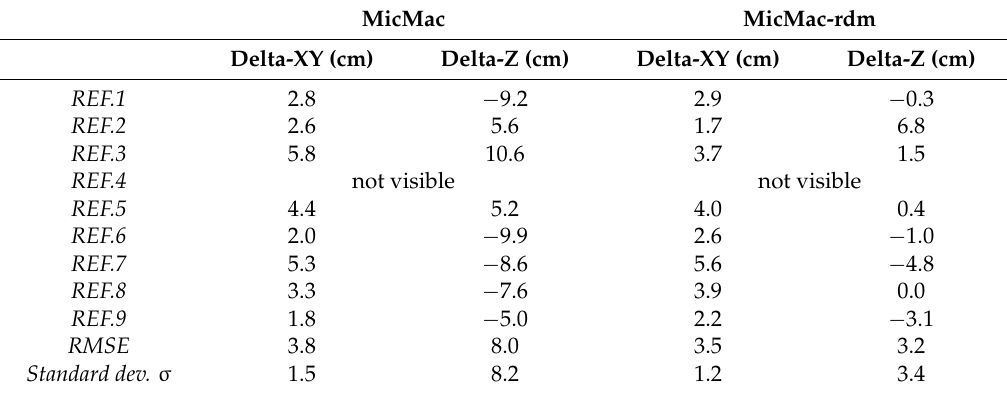
Table 1. Accuracy of the reconstruction with scenario 1 using MicMac and MicMac with the refined distortion model (MicMac-rdm). Delta-XY and Delta-Z are respectively the horizontal/vertical gaps between the GPS position of reference targets (REF) and their position on the computed orthophotograph and DSM. MicMac MicMac-rdm Delta-XY (cm) Delta-Z